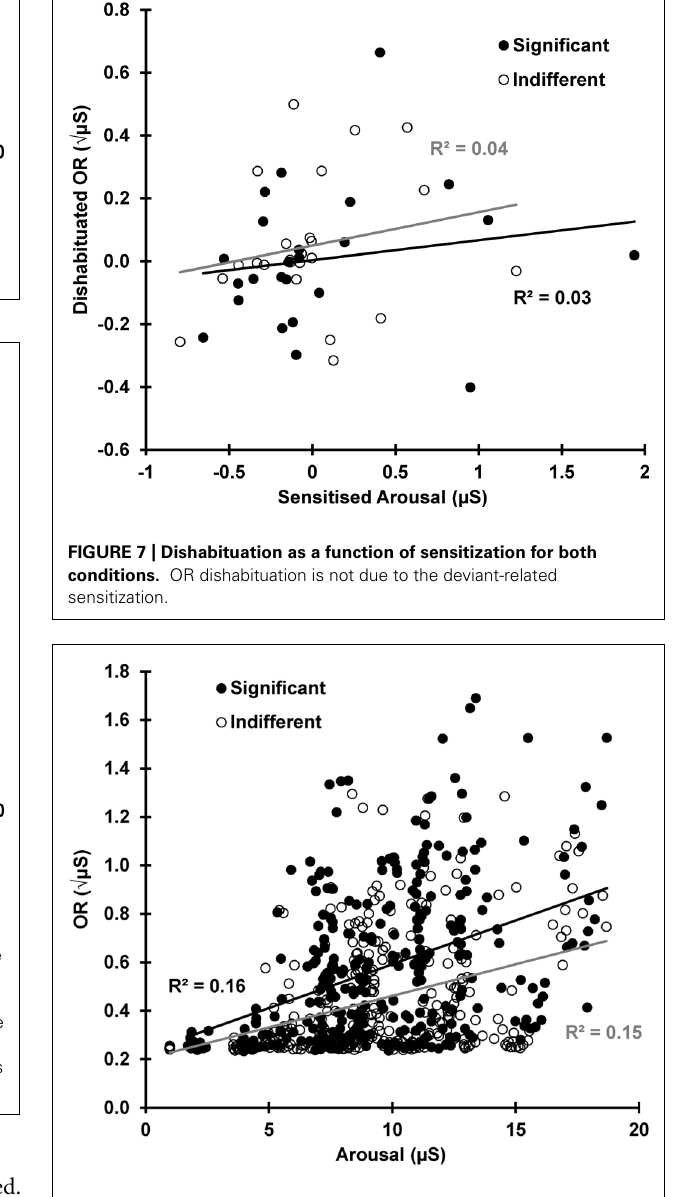
FIGURE 8 | For each subject and trial, the SCR is plotted against the pre-stimulus SCL, separately for indifferent and significant. The OR is dependent on the current arousal level in both